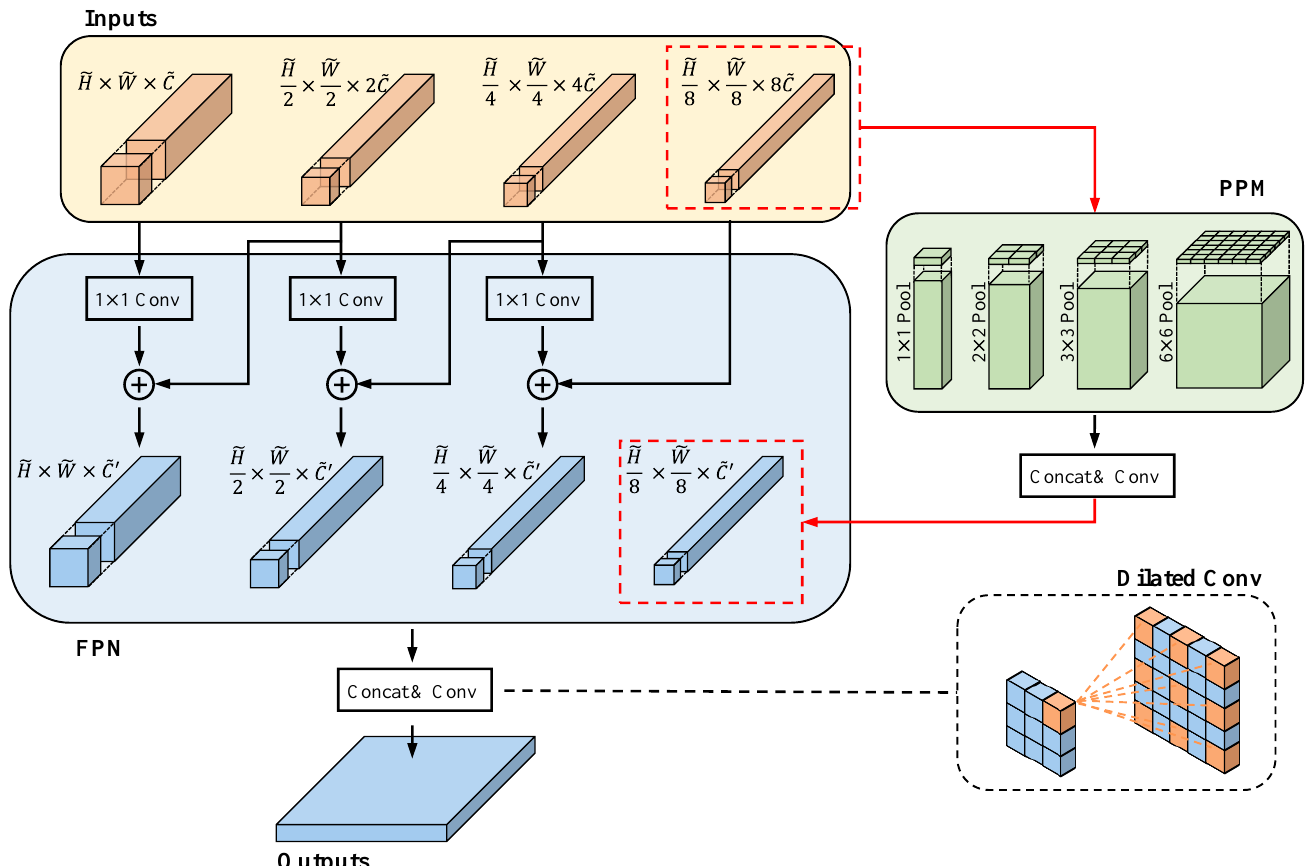
Figure 4. The structure of Dilated-Uper